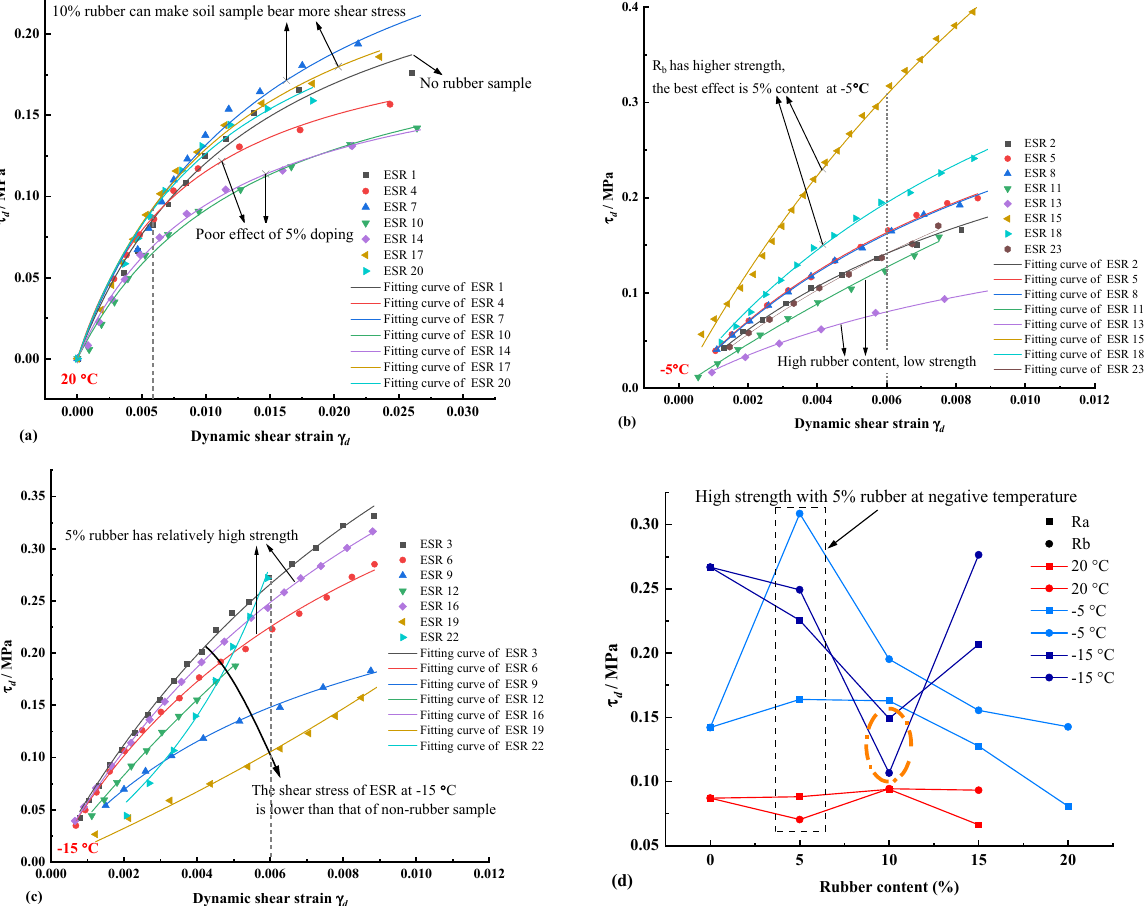
Figure 8. Backbone curve and upper shear stress limit of expansive soil under different rubber forms and yields. ( a ) 20 °C ESR specimens. ( b ) − 5 °C ESR specimens. ( c ) − 15 °C ESR specimens. ( d ) Upper shear stress limit varies with rubber content. Table 3. Regression analysis constants a and b for Equation (4)—H-D model.